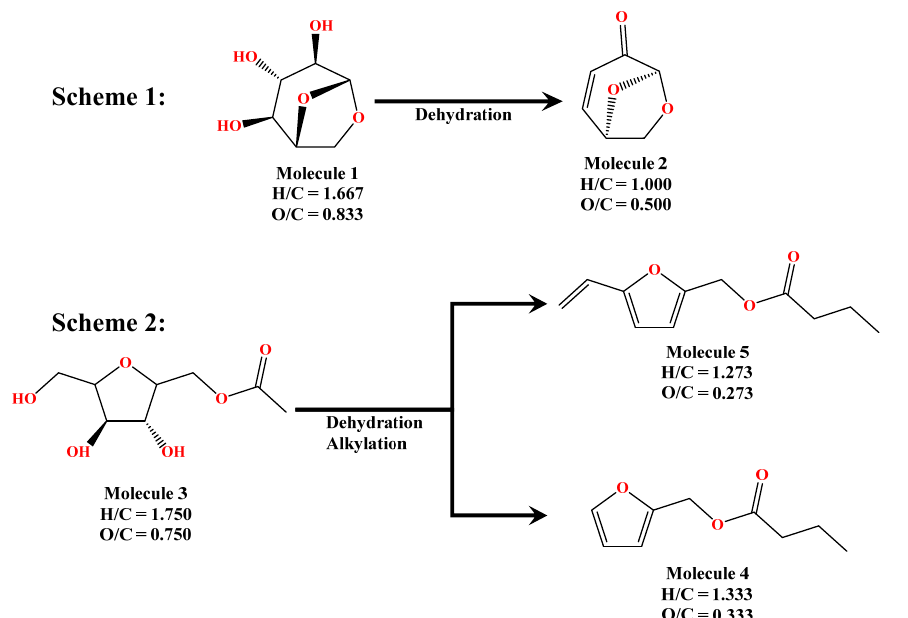
Figure 7. Conversion routes for the proposed structures for molecules 1, 2, 3, 4, and 5.